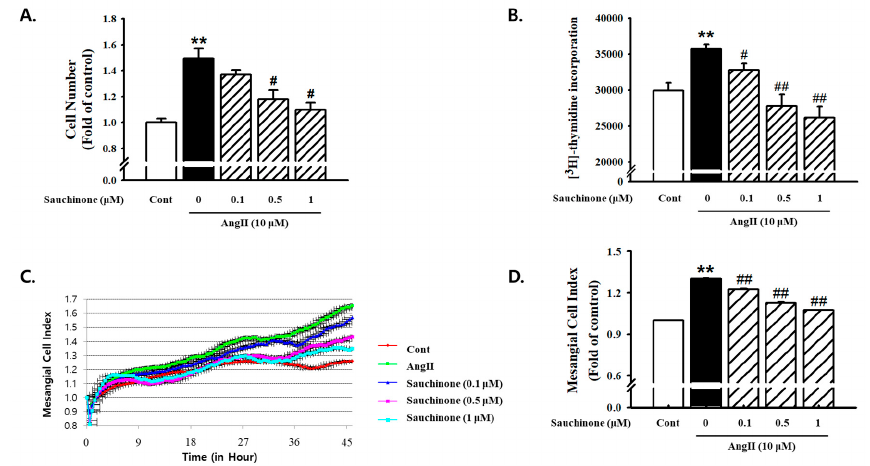
Figure 1. Effects of sauchinone on renal mesangial cell proliferation. Human mesangial cells were treated with angiotensin II (AngII) (10 μ M) and incubated with or without sauchinone (from 0, 0.1, and 1 µ M) for 48 h. ( A ) Cell number results of mesangial cells using Countess ™ cell counting, ( B ) cell proliferation results using [ 3 H]-thymidine incorporation assay, ( C ) results of mesangial cell index using xCELLigence RTCA DP Real time cell analyzer, and ( D ) quantification results of mesangial cell Index (fold of control). Results are expressed as the mean ± S.E. from four independent experiments. ** p < 0.01 vs. control; # p < 0.05, and ## p < 0.01 vs. AngII